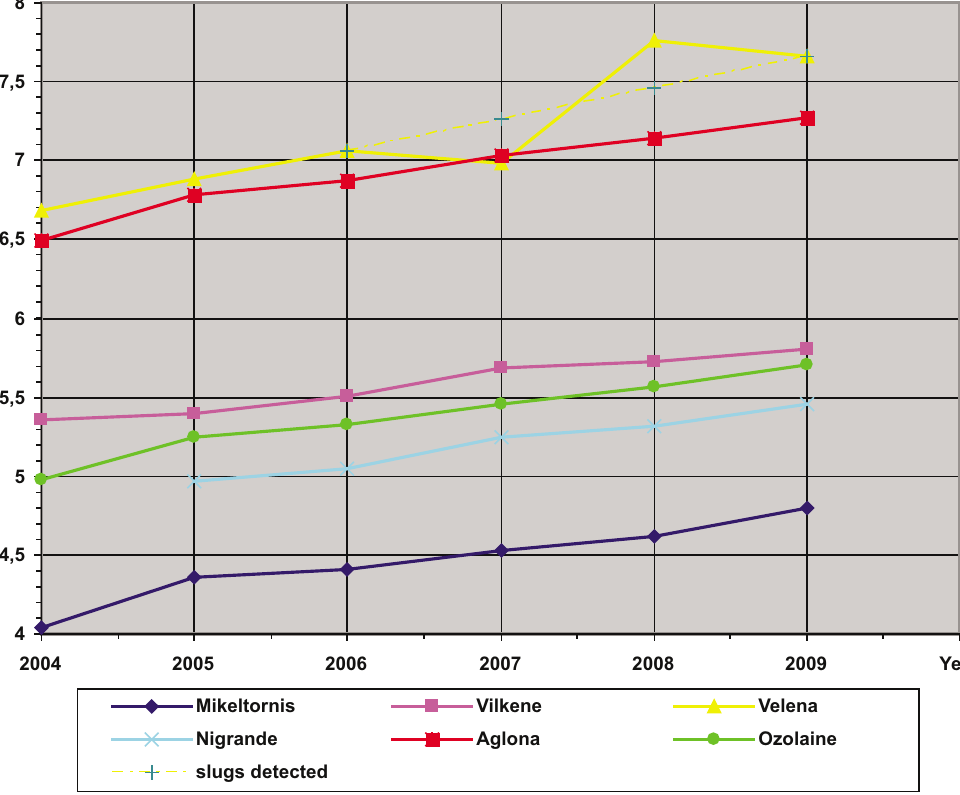
Fig. 3. The variation of declination mean annual values in degrees (during